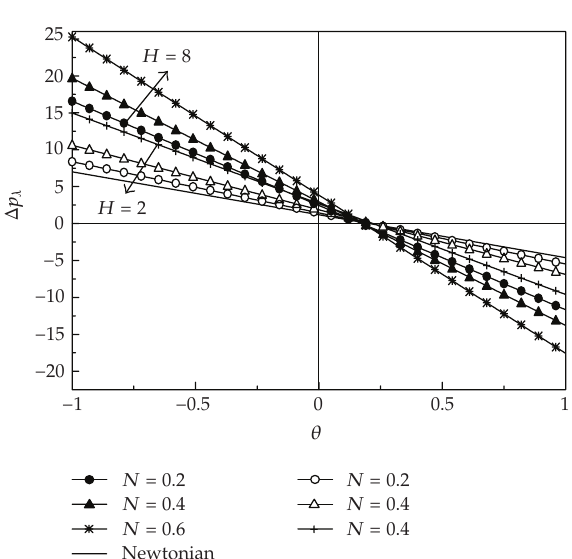
Figure 3: The pressure rise versus flow rate for α (cid:8) 0 . 4 , m (cid:8) 2 , H (cid:8) 2, and H (cid:8) 8 at di ff erent values of N .